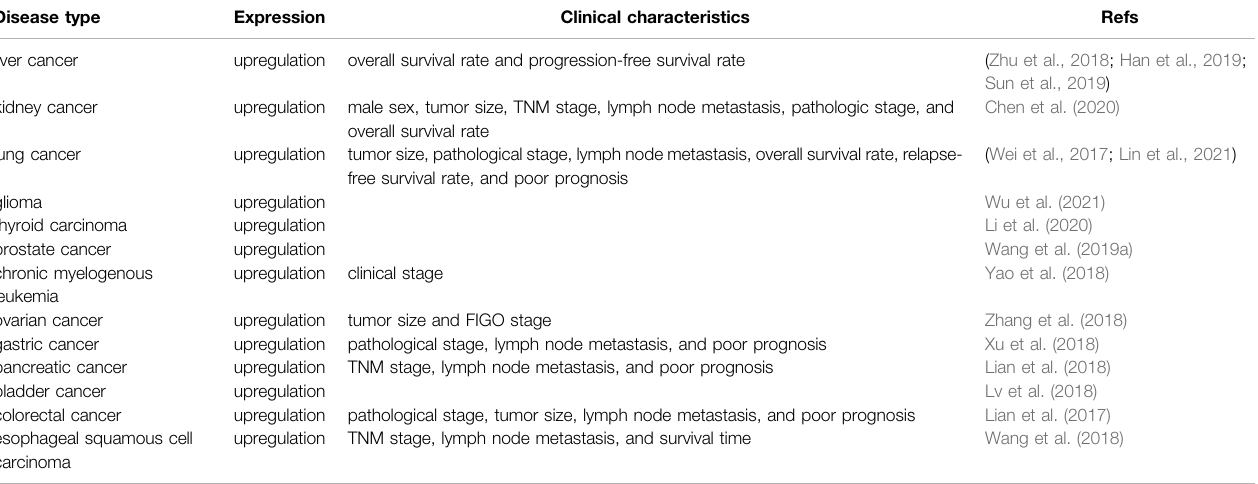
TABLE 1 | DUXAP10 expression and clinicopathological features in